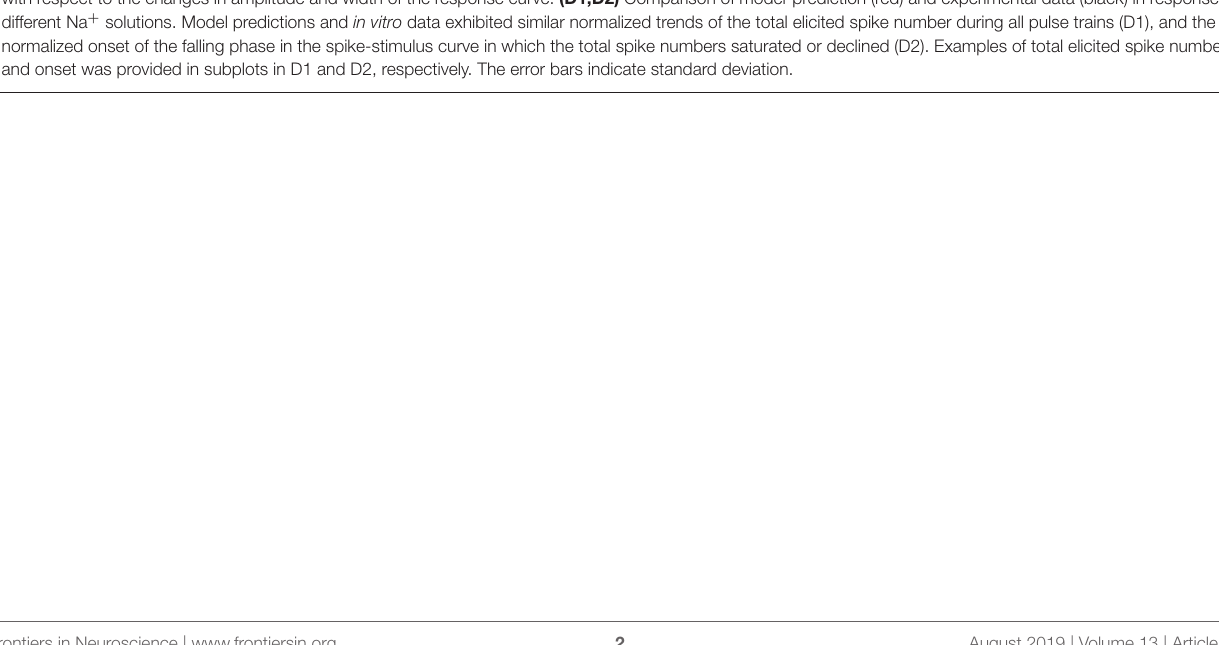
Frontiers in Neuroscience |